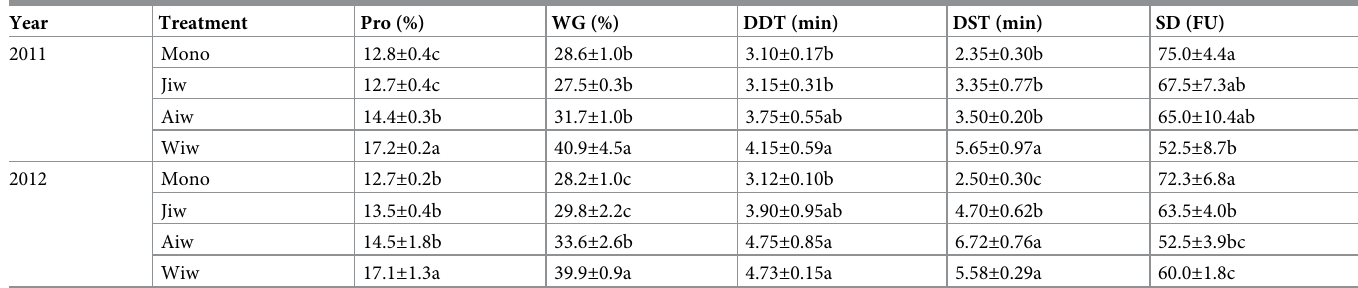
Table 4. The grain quality of wheat in monoculture configurations and 3 different fruit tree-wheat intercropping systems in 2011 and 2012. Year